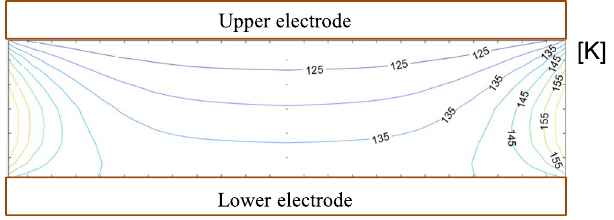
Figure 3. Calculated neutral gas temperature profile between the two electrodes. The neutral gas temperature is obtained by solving the time-independent heat equation (Laplace equation). Temperatures of the lower electrode, upper electrode, and chamber wall are assumed to be 140 K, 120 K, and 300 K, respectively. The contour plot of the temperature seems similar to the shape of the observed dust clouds.